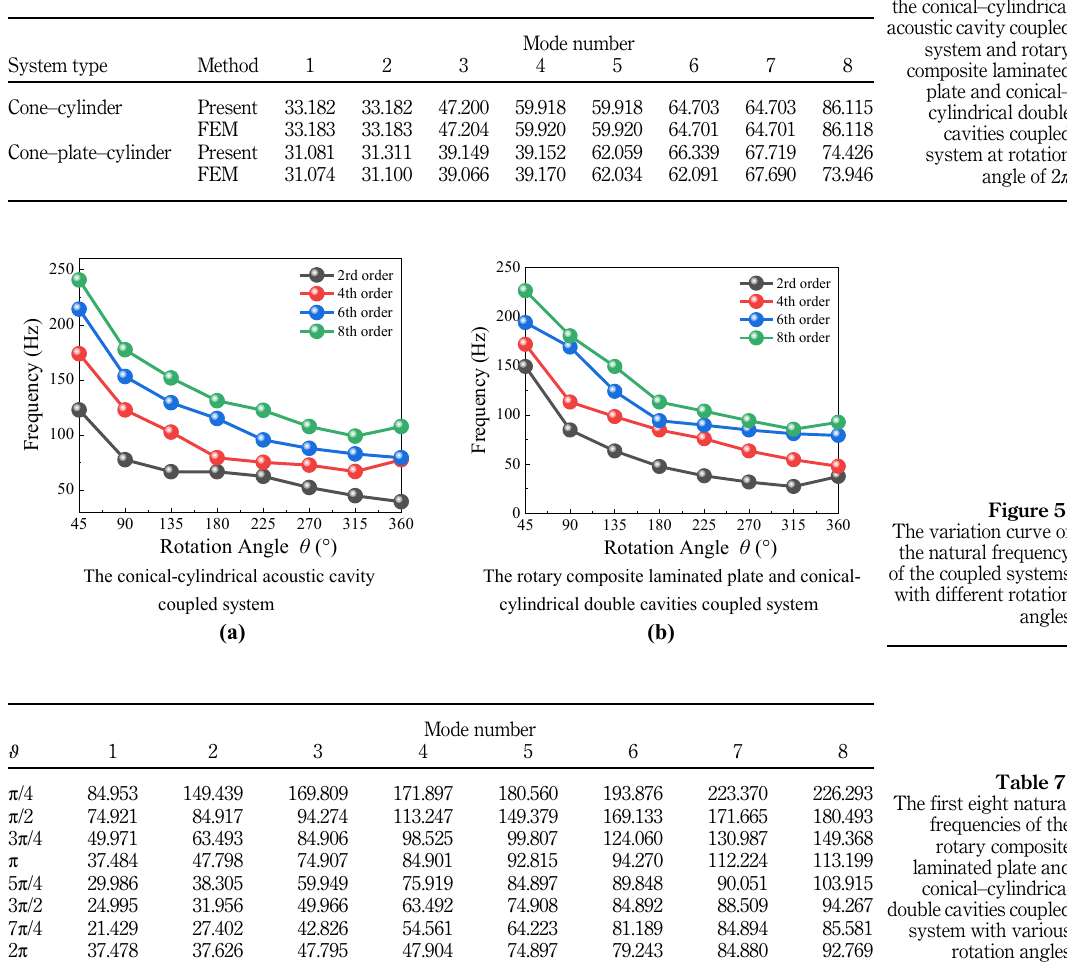
Table 6. Accuracy analysis of